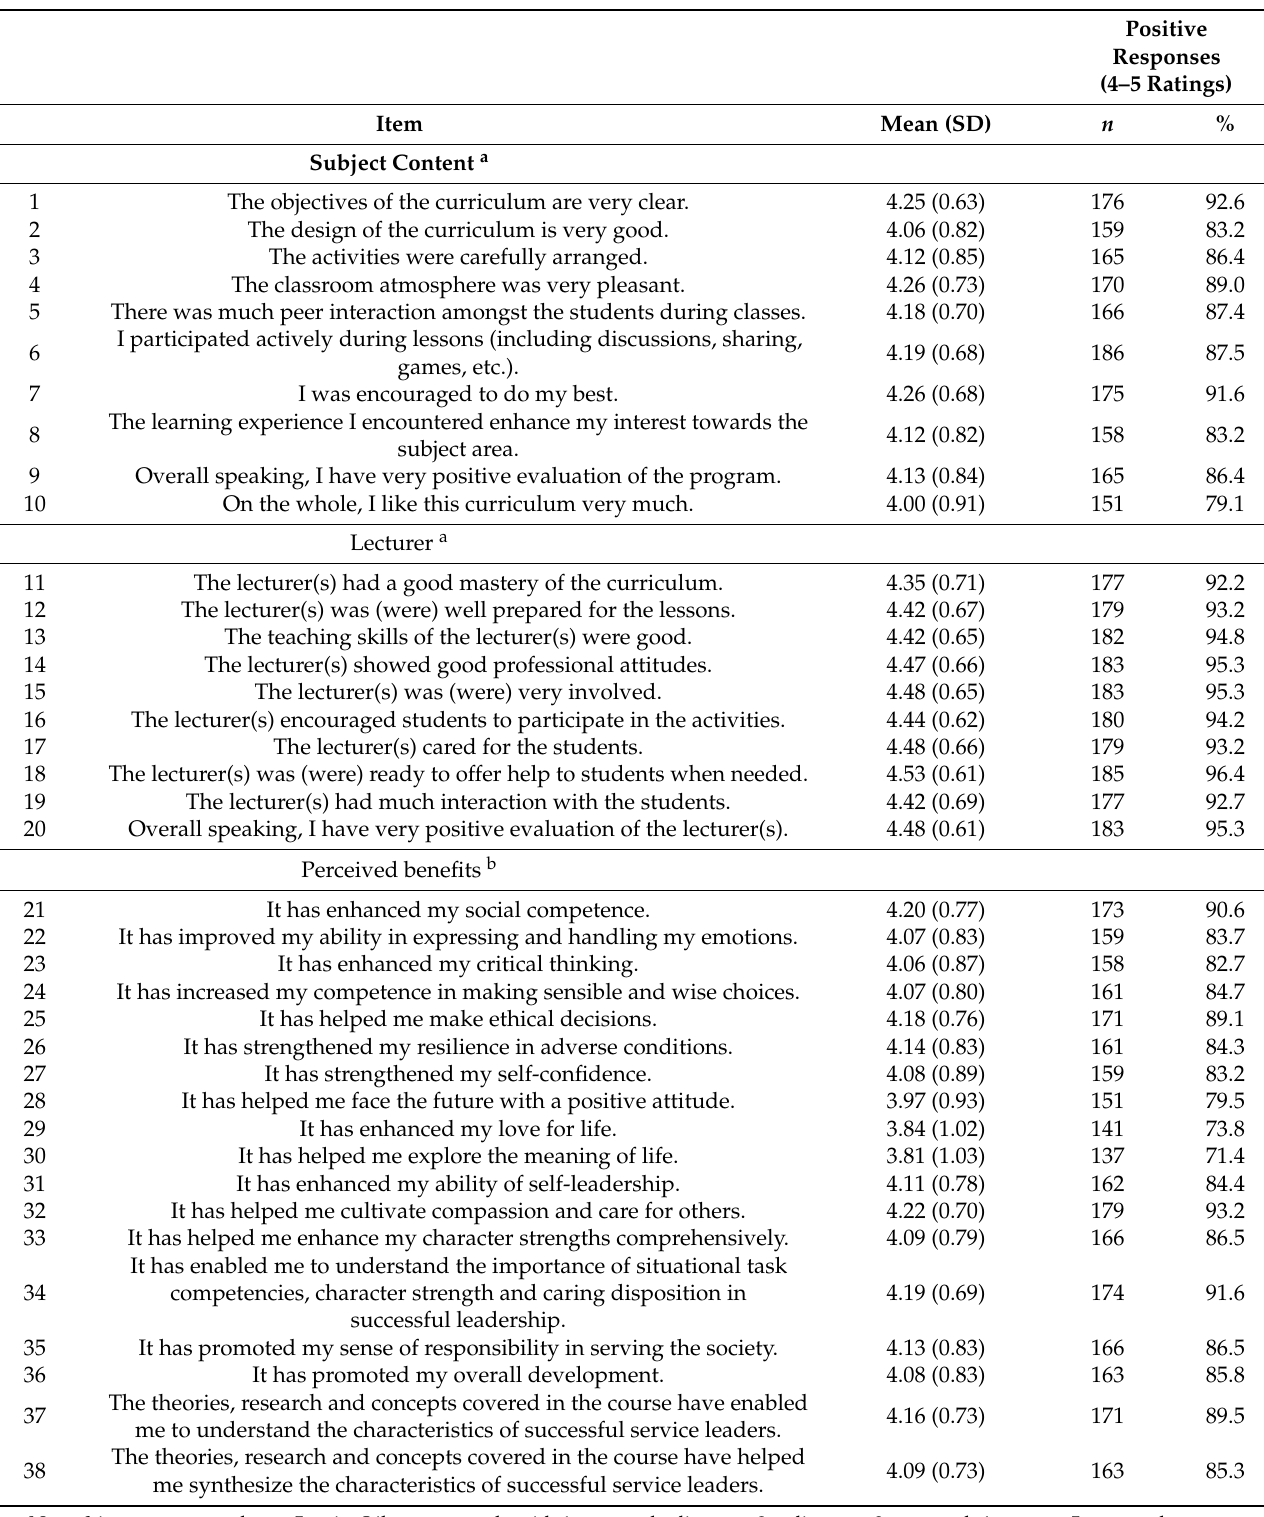
Table 3. Descriptive statistics and positive responses from the Subjective Outcome Evaluation by university students (service providers) ( n =